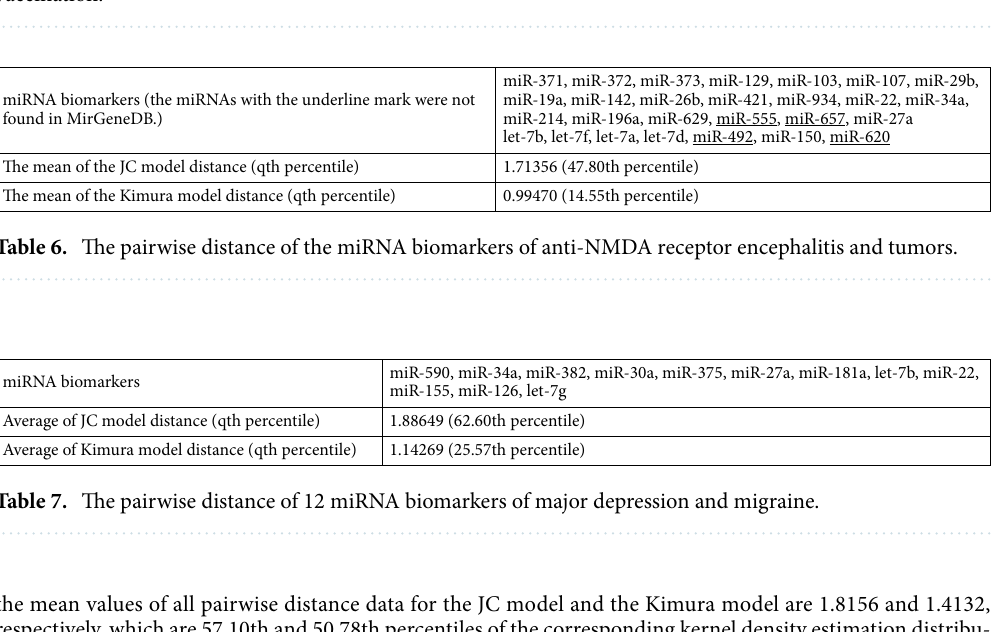
Table 5. The pairwise distance of the miRNA biomarkers of anti-NMDA receptor encephalitis and vaccination.